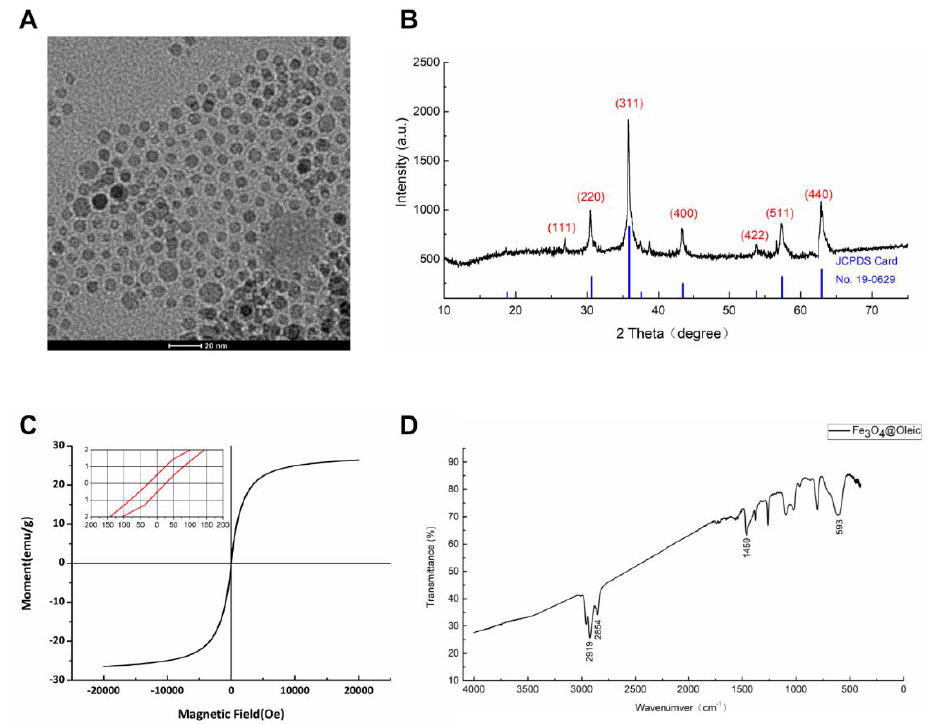
Figure 2. Characterization of SPIONs (F 3 O 4 nanoparticles). ( A ) Representative transmission electron microscopic image of F 3 O 4 nanoparticles. The scale bar on the TEM image equals 20 nm. ( B ) X-ray diffraction patterns of F 3 O 4 nanoparticles. ( C ) VSM curve of F 3 O 4 nanoparticles. ( D ) FTIR spectrum of F 3 O 4 nanoparticles.